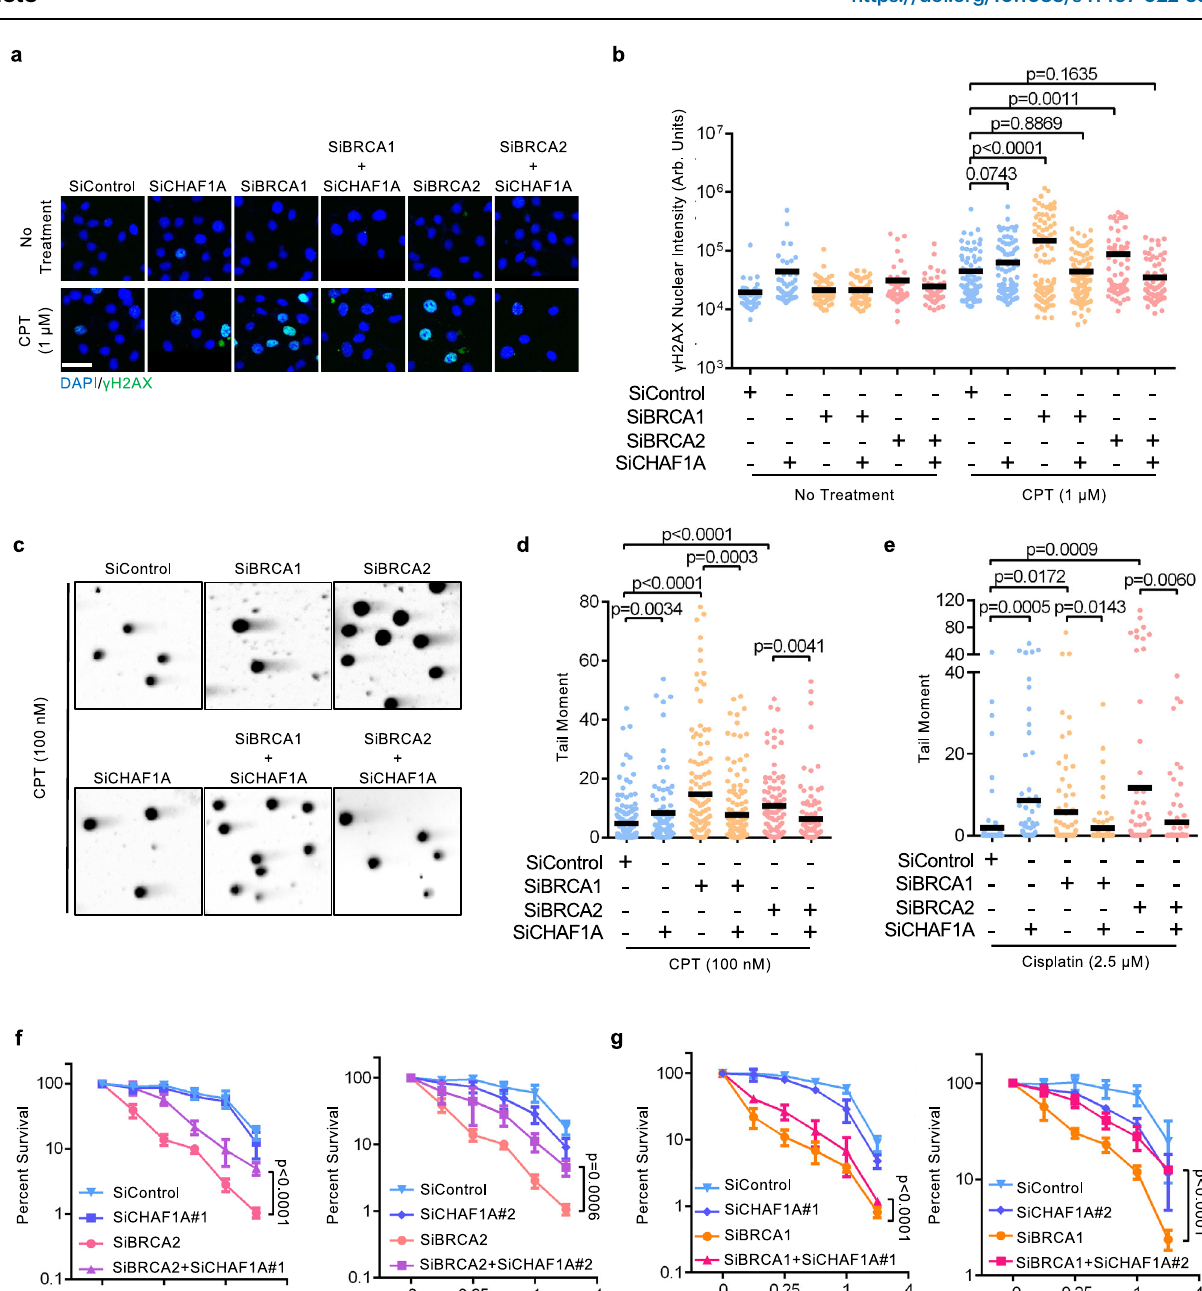
Fig. 2 | Loss of CAF-1 suppresses genomic instability in BRCA-de fi cient cells. a , b γ H2AX immuno fl uorescence experiment showing that CHAF1A depletion suppresses CPT-induced DNA damage accumulation in BRCA1 or BRCA2-depleted cells. HeLacells were treated with 1 μ M CPTfor 1h followedby media removal and chase in fresh media for 3h. Representative micrographs (scale bar represents 50 μ m) ( a ) and quanti fi cations ( b ) are shown. At least 50 cells were quanti fi ed for eachcondition.Themeanvaluesarerepresentedonthegraph,andthe p -values( t - test, two-tailed, unpaired) are listed at the top. Western blots con fi rming the co- depletions are shown in Supplementary Fig. 2a. c – e Neutral comet assay showing that CHAF1A depletion suppresses CPT-induced ( c , d ) and cisplatin-induced ( e )